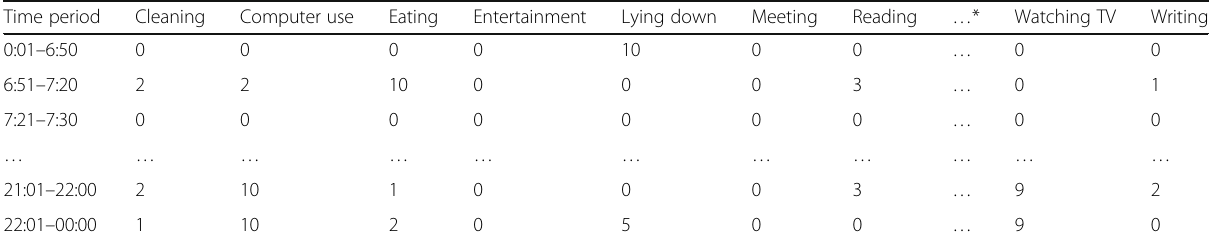
Table 1 Sample time – activity table Time period